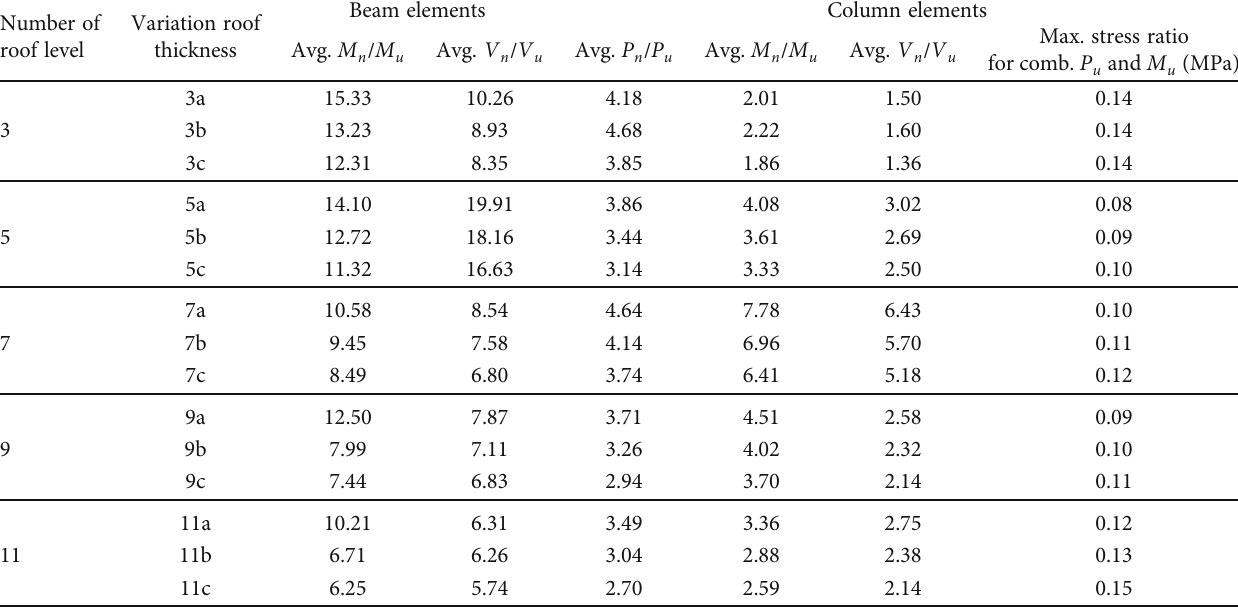
Table 3: Structural element design check for the number of roof levels 3 to 11.